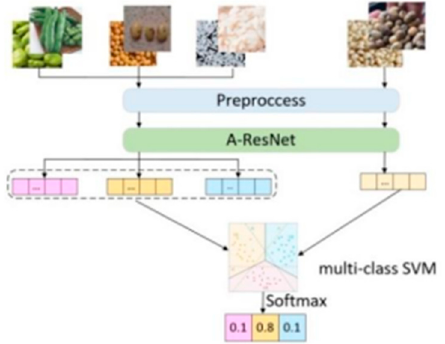
Figure 7. The structure diagram of A-ResNet meta-learning model.